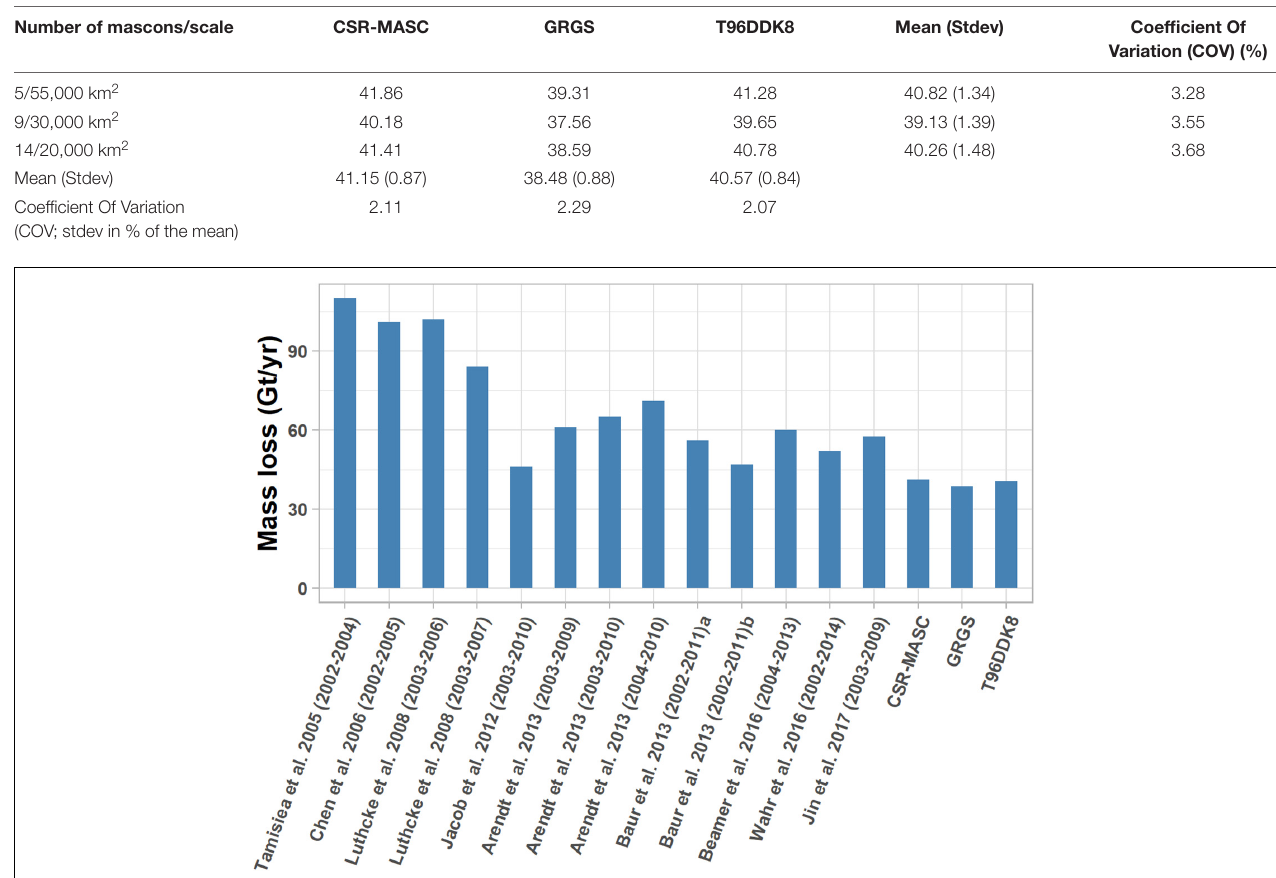
Frontiers in Earth Science |